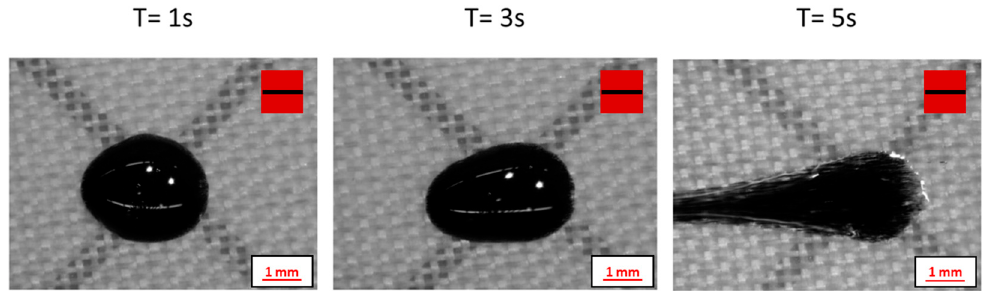
Figure 4. Optical microscopy images of droplet deformation for different magnetization times at magnet separation distance of 30 mm (Formulation: 10SF). Red squares with a black bar indicate the direction of the magnetic field.